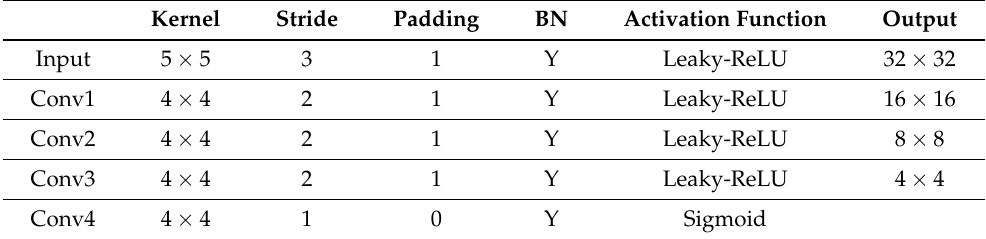
Table 2. Specific structure of the discriminative